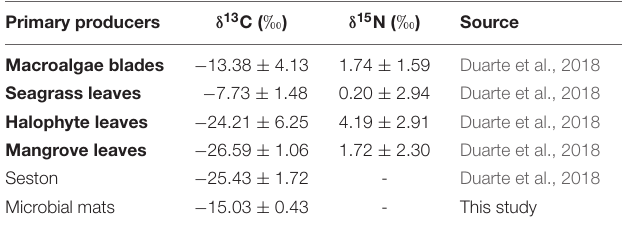
TABLE 2 | Mean ( ± SD) δ 13 C and δ 15 N of potential sources for Red Sea seagrass and mangrove sediments.